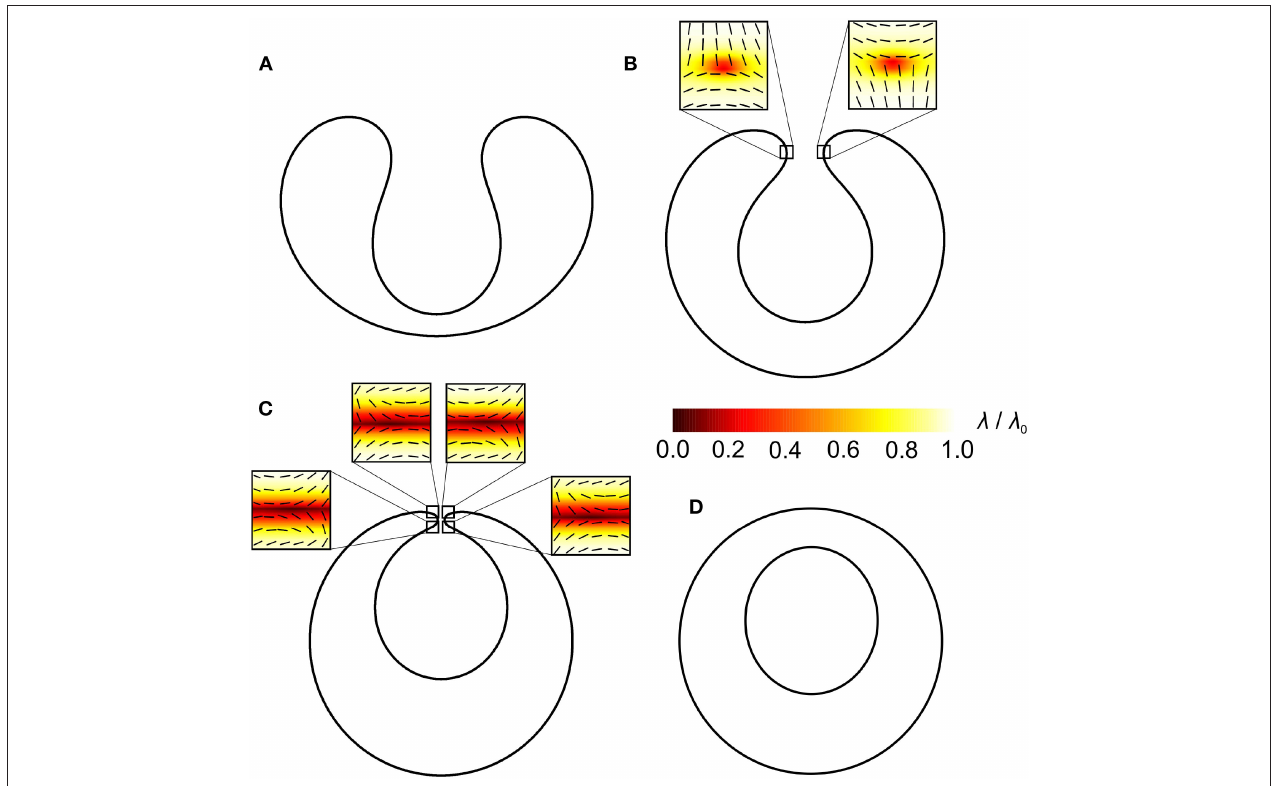
FIGURE 4 | Invaginated stomatocytes with topological antidefects in their neck region. The sequence demonstrates the transformation from a relatively opened stomatocyte (A) through the intermediate stomatocyte (B) to the stomatocyte with a thin neck (C) . Finally, the stomatocyte neck rupture results in the formation of one closed membrane surface inside another (D) . The positions of antidefects are marked by small squares. Orientational ordering profiles with the superimposed nematic director fields in the vicinity of topological antidefects are magnified. R /ξ 21, where R represents a typical linear dimension of a shape and ξ the nematic order = correlation length defined in section